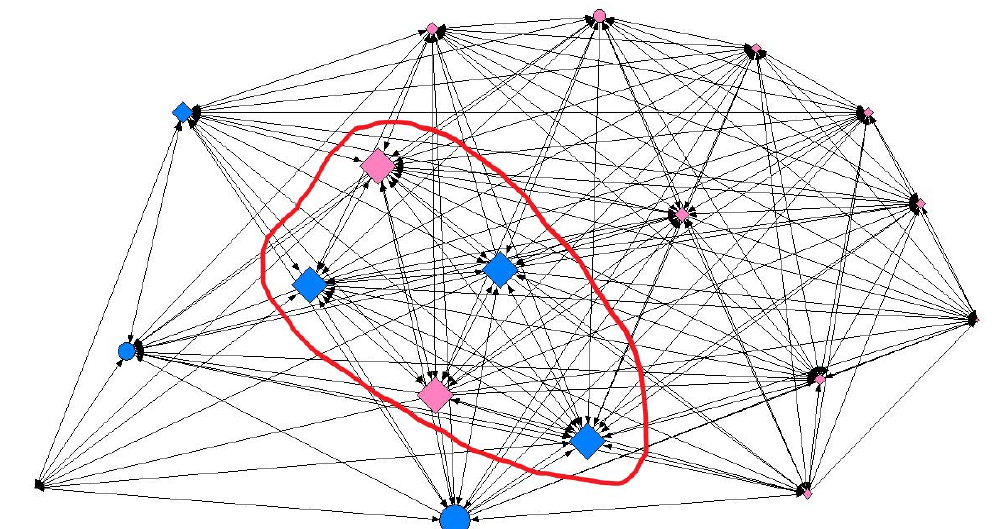
Figure 2. Graphical representation of one of the networks in the study at the minimum contact intensity level, where node size indicates the capacity for intermediation (betweenness). Females are shown in pink, males in blue; circles represent individuals with a medium ‐ low SES and diamonds a high SES. Graphs were produced using UCINET software [40].